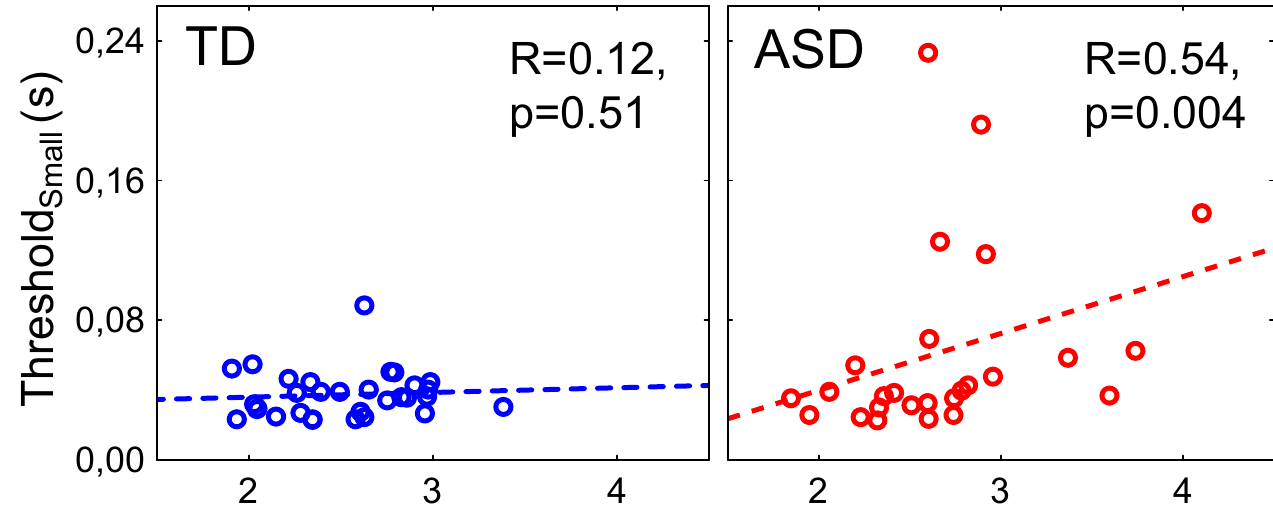
Fig 8. Spearman correlations between gamma response suppression index (GRSI) and duration threshold for the small grating. Lower GRSI values indicate stronger velocity-related suppression of the gamma response.